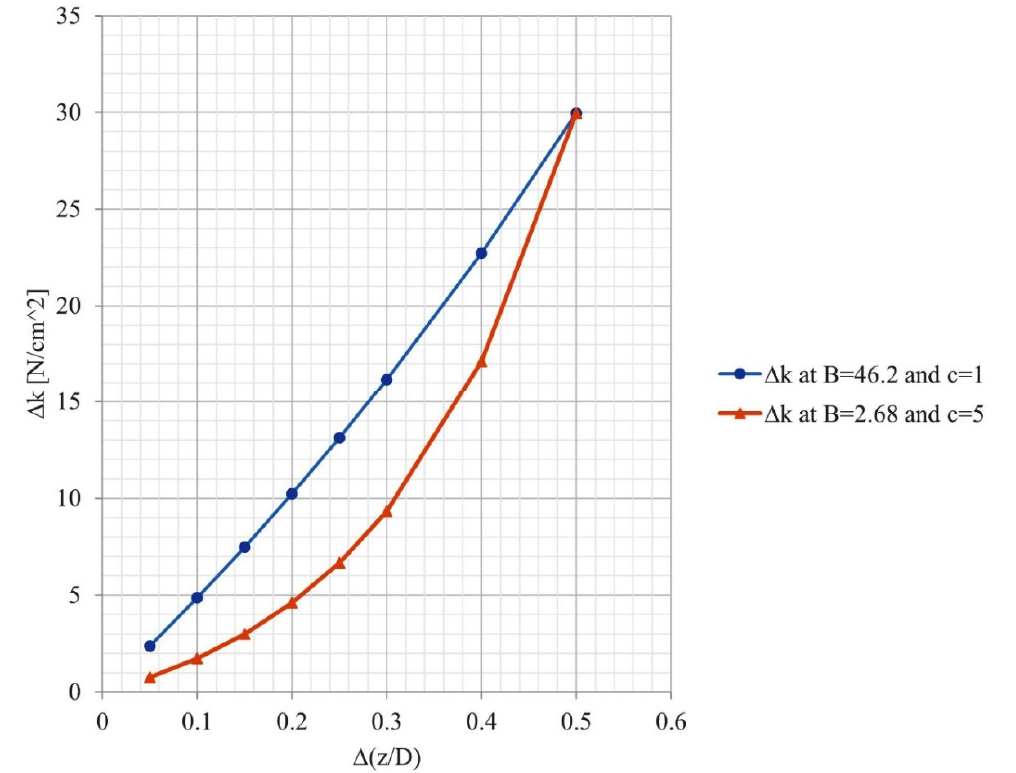
Figure 6. Model of the relationship of ∆k versus ∆(z/D).